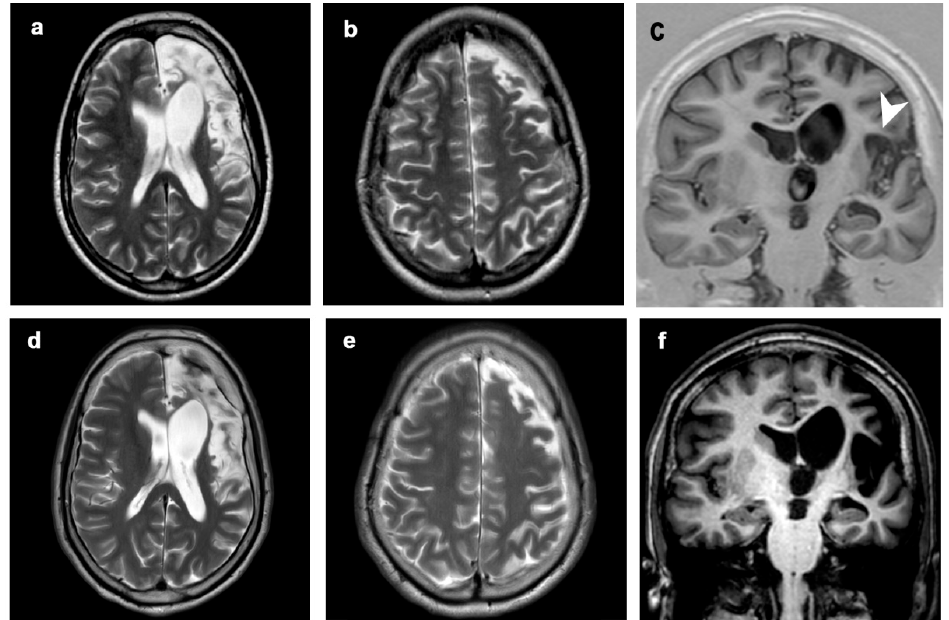
Figure 4. Patient 2, progression of the disease in 21 years. Axial ( a , b , d , e ) T2-weighted images, coronal T1-inversion recovery ( c ) and T1-weighted image ( f ) at ( a – c ) 5 years (first MRI scan) and ( d – f ) 21 years from clinical onset (last MRI scan). The disease showed mild progression over time, involving left perisylvian region (including frontal, insular and temporal structures, arrowhead). Clinical symptoms progressed from seizures at onset to seizures, focal deficits, EPC, cognitive and behavioral disorders.